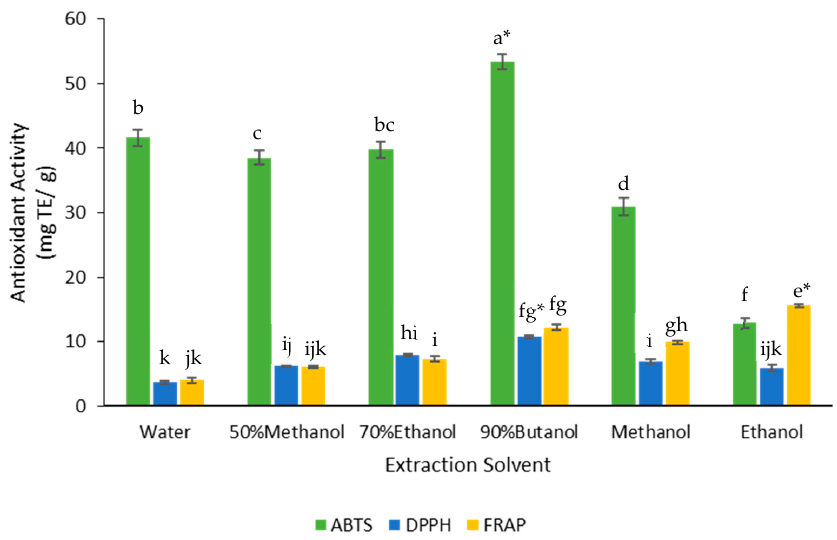
Figure 5. Effect of solvent on the antioxidant capacity of the FD crude extracts. The values were the means ± SD of three replicate extractions for each solvent. Columns not sharing the same superscript letter were significantly different at p < 0.05. * indicated the highest antioxidant activity. TE, Trolox equivalents.